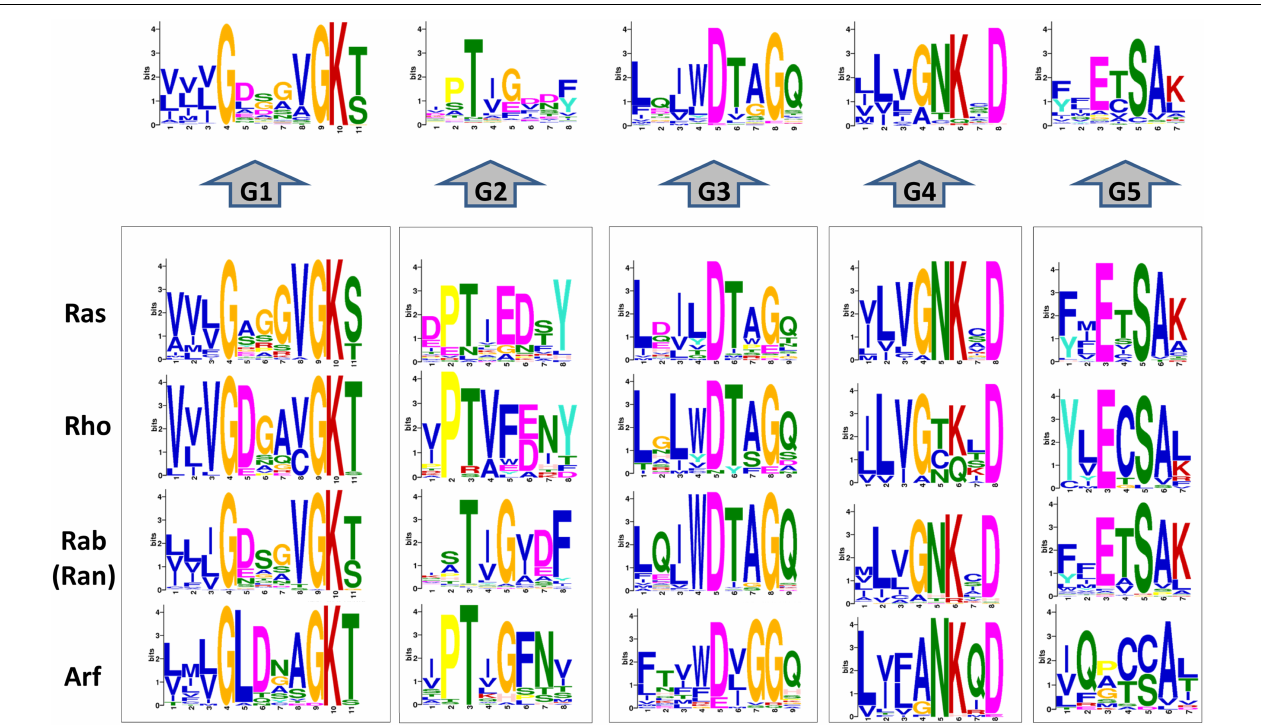
FIGURE 4 | Conservation analysis of the 167 human G-domain of Ras superfamily and its subfamilies (http://meme-suite.org/). Considering that the Ran only has one sequence and is a branch of Rab subfamily, we incorporate Ran into Rab family.